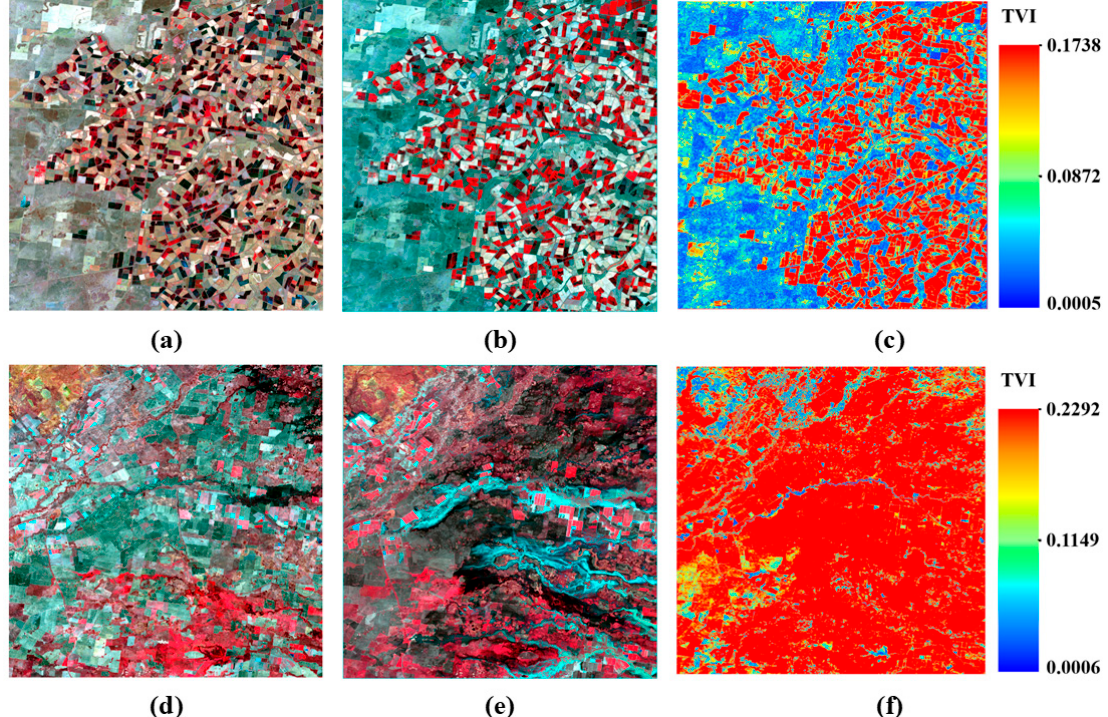
Figure 3. Examples of TVI maps. ( a , b ) are the Landsat color-infrared images at Coleambally site acquired on 4 December 2001 and 5 January 2002; ( c ) is the corresponding map of temporal variation index (TVI) calculated for each pixel at Coleambally. ( d , e ) are the Landsat color-infrared image at Gwydir site acquired on 26 November 2004 and 12 December 2004; ( f ) is the corresponding map of LHI calculated for each pixel at Gwydir.